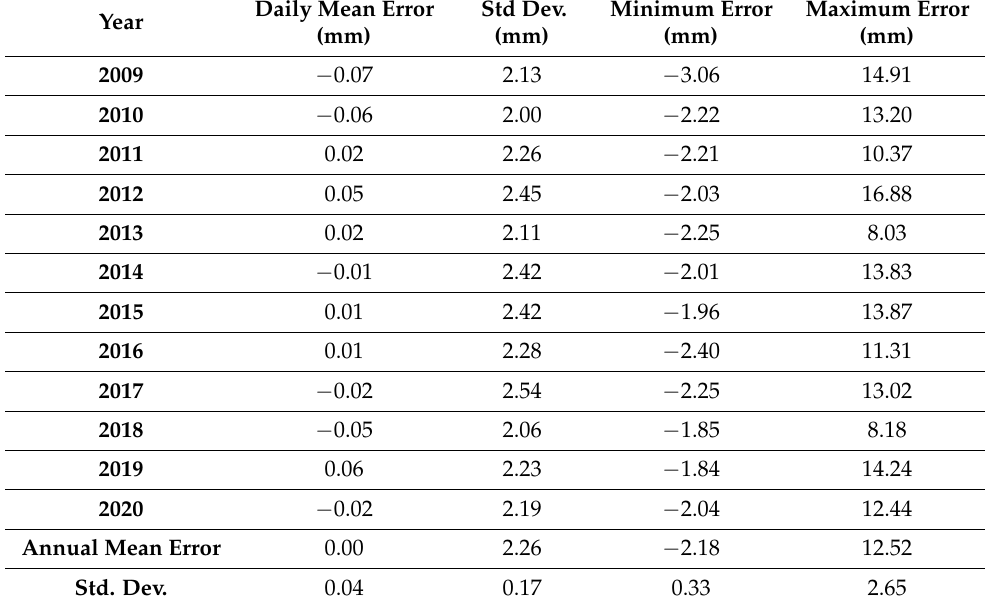
Mayaguez, Puerto Rico. Table also includes annual values. All values are in millimeters.